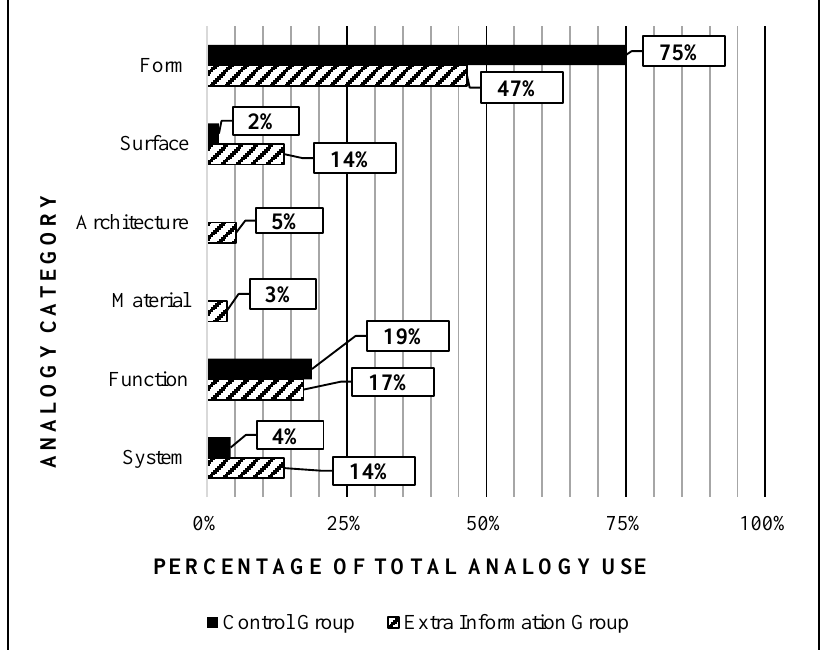
Figure 4. Population of analogy category breakdown for both groups.